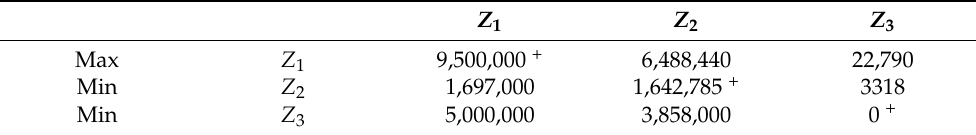
Table 5. PIS Payoff